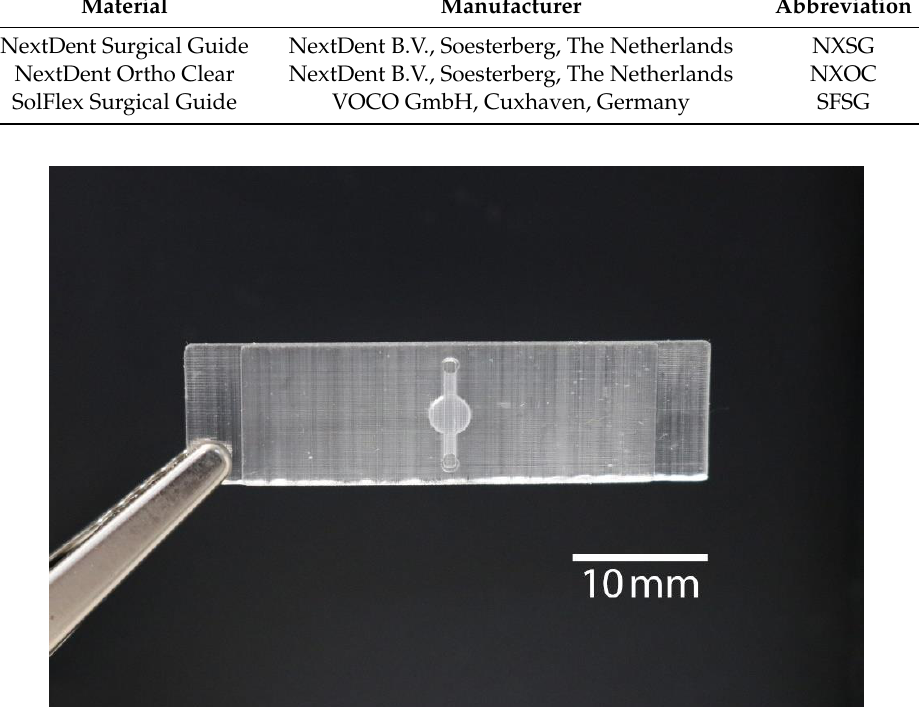
Figure 1. 3D printed monolithic microfluidic device with buried real-time recombinase polymerase amplification (rtRPA) microreactor.